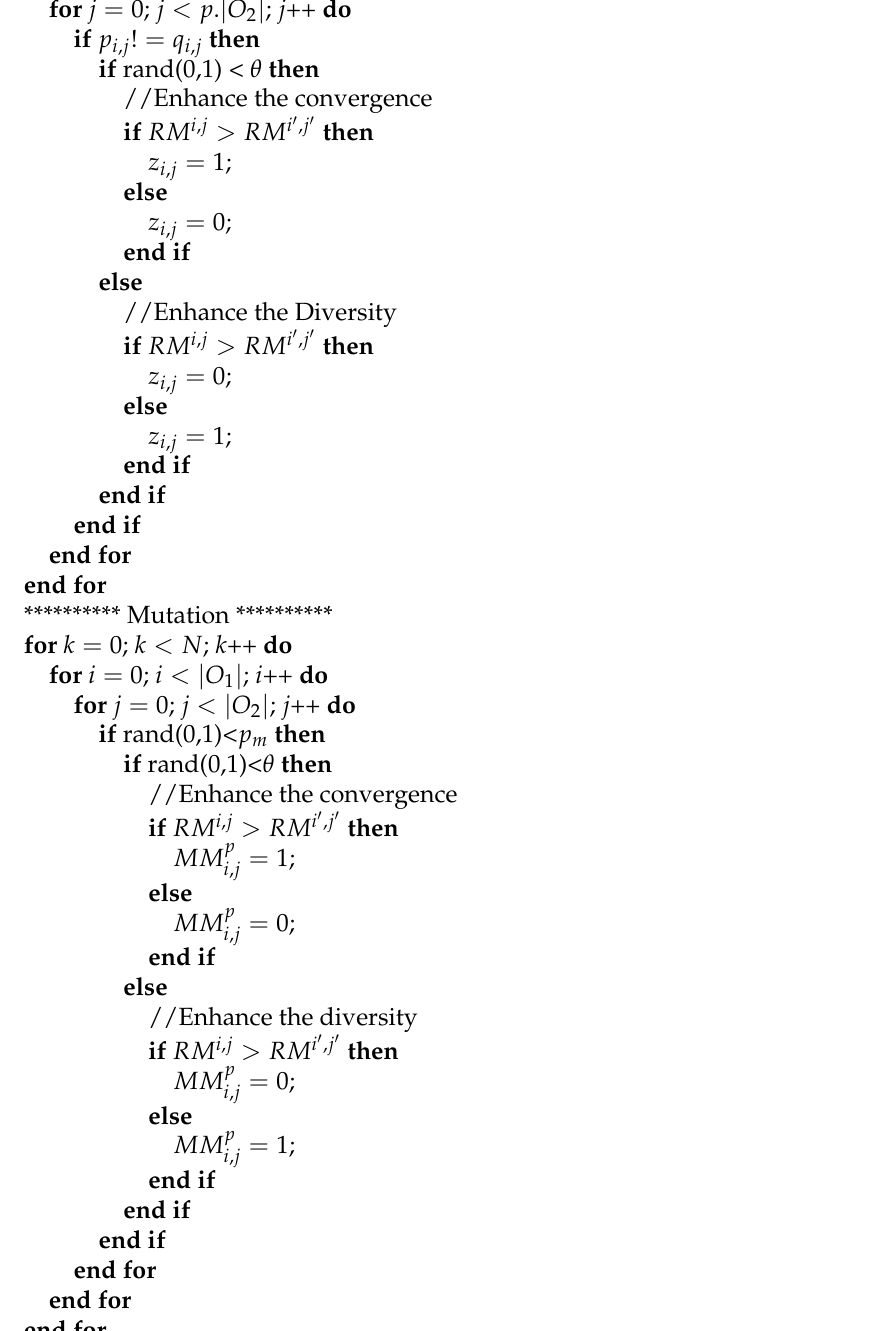
Algorithm 3 Relevance matrix-based crossover and mutation ********** Crossover